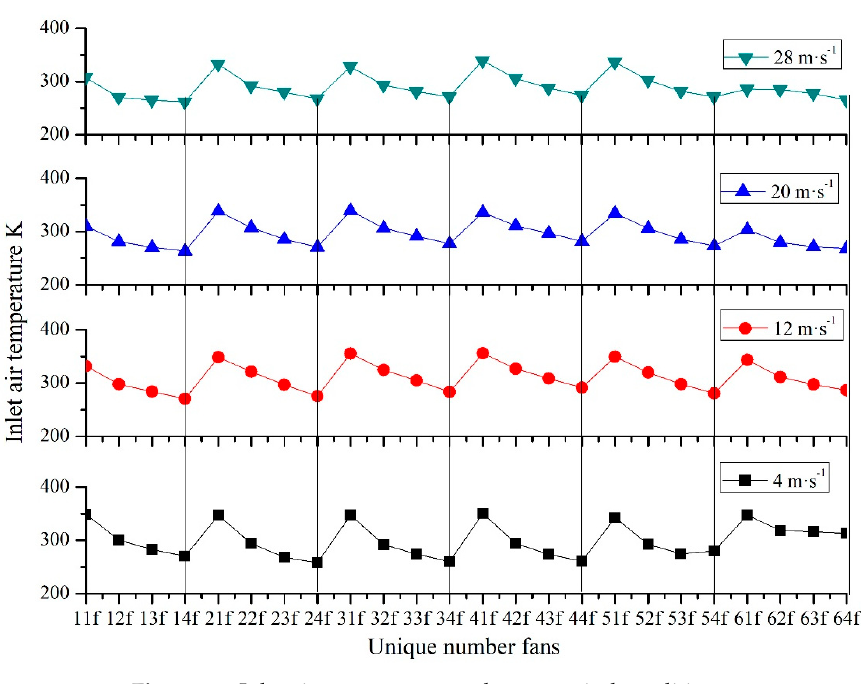
Figure 10. Inlet air temperature under crosswind conditions.